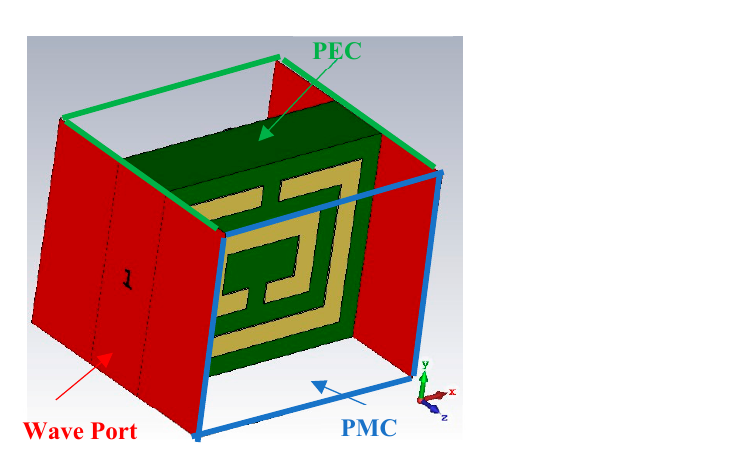
Figure 2. Perfect boundary condition and excitation applied to single unit-cell using CST-MWS.